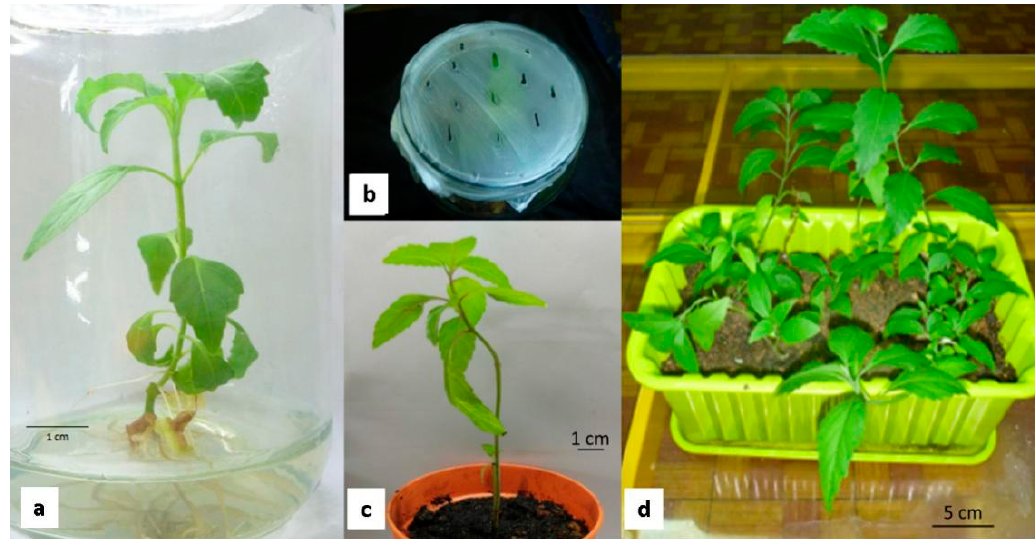
Figure 1. Acclimatization of regenerated plantlets of Orthosiphon stamineus ; ( a ) in vitro grown plantlet, ( b ) acclimatization after 30 days, ( c ) acclimatization after 90 days, and ( d ) several successfully acclimatized plantlets after 6 months.